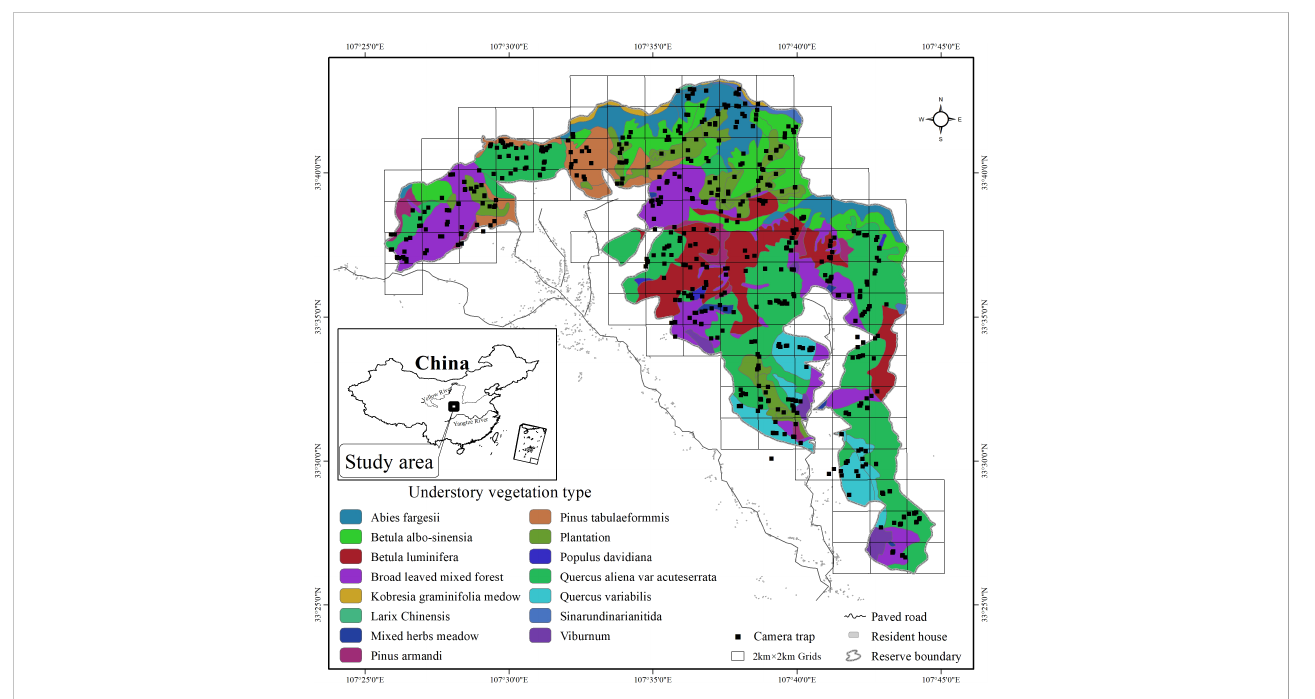
FIGURE 1 Locations of camera trap sites in 4 km 2 grids and understory vegetation types in Changqing National Nature Reserve. Inset map shows the study area location in central